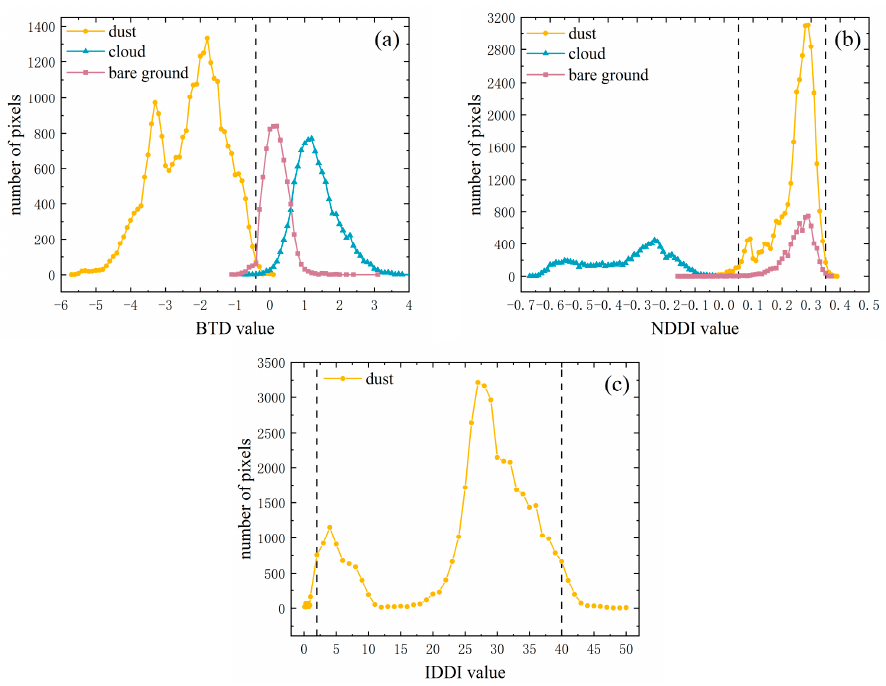
Figure 2. Frequency distribution of the BTD ( a ), NDDI ( b ), and IDDI ( c ) values for dust events.